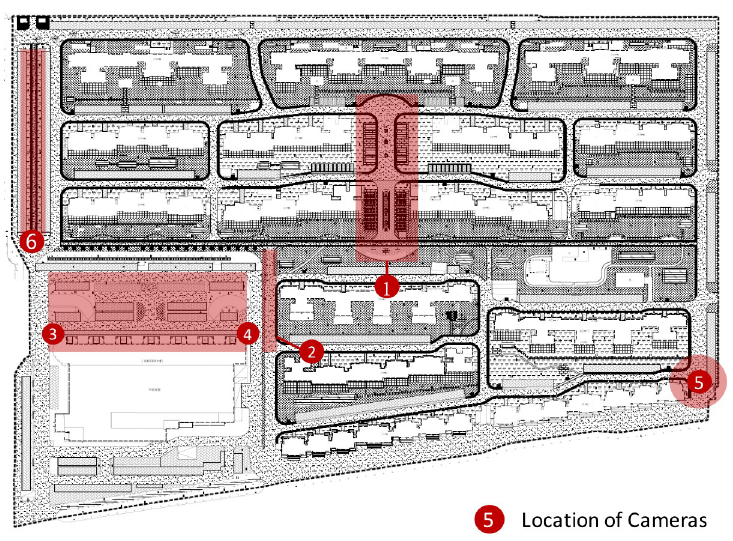
Fig 4. Location of photographic devices.